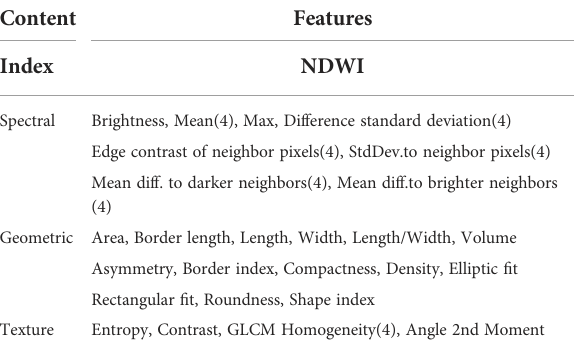
TABLE 1 Categorical features including blue, green, red, and NIR bands.